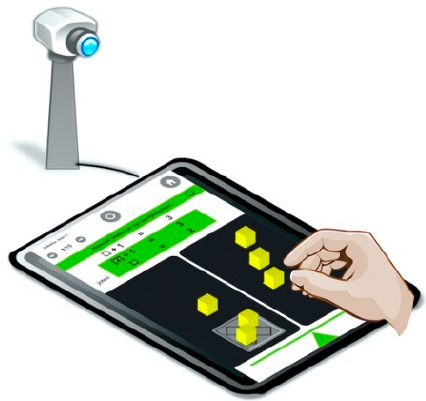
Figure 2. Alternative set-up of the system with a tablet running Windows.